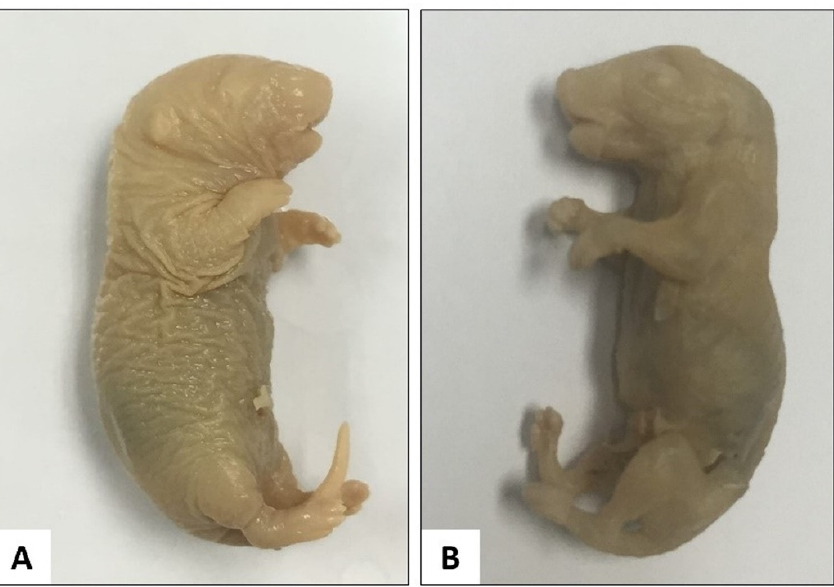
Figure 1. Sprague Dawley rat before skinning ( A ) and after skinning ( B ). Subsequently, the mid-dorsal skin edges were pulled gently apart from the body by using micro-dissecting forceps towards the ventral surface of the rat. The remaining skin of the hands, feet and tail were also removed as much as possible. Since it was not practical to remove all the skin from the digits, the skin on the dorsum of each toe was snipped off using micro-dissecting spring scissors or micro-dissecting forceps up to the proximal interphalangeal joint. The interscapular fat pad was also manually